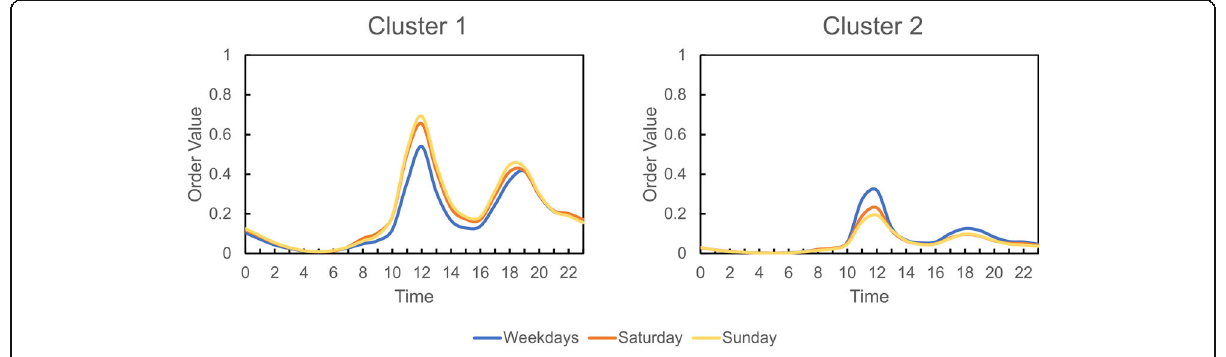
Fig. 6 Average order value over time of cluster results for k = 2